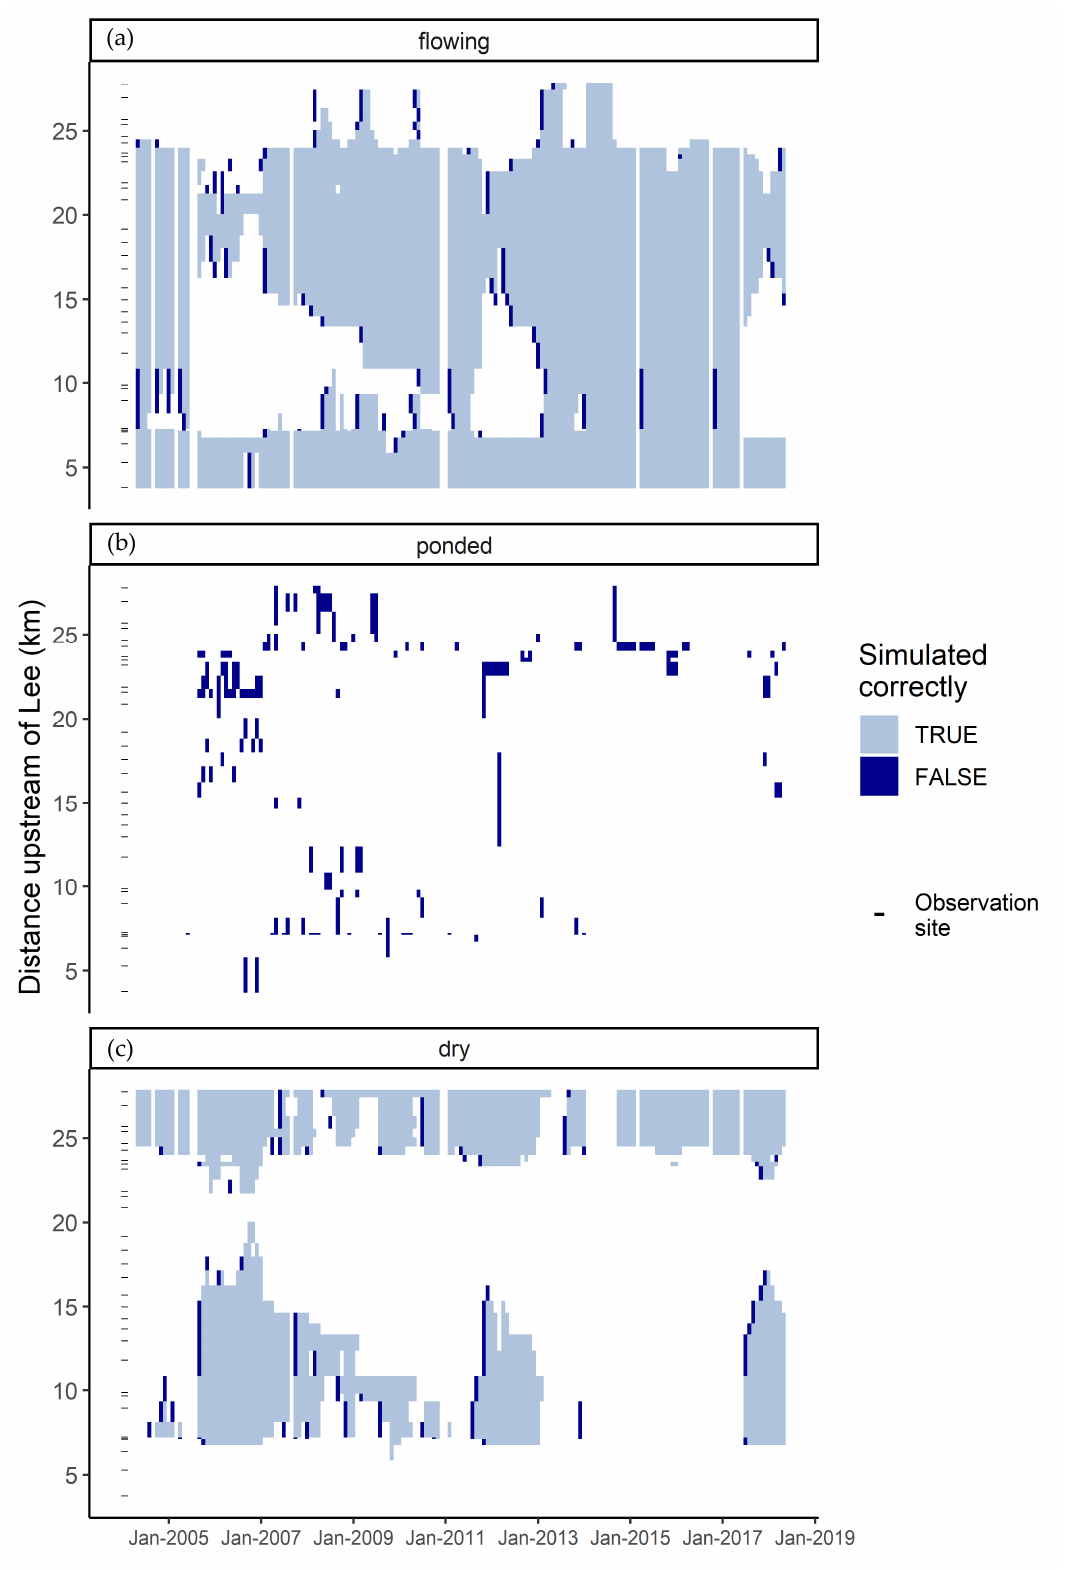
Figure 7. Monthly time series indicating whether flowing ( a ), ponded ( b ), and dry ( c ) states were simulated correctly and when and where the states were observed on the Misbourne. Hydrological state is assumed to be consistent along observed reaches due to the high spatial resolution of the data.